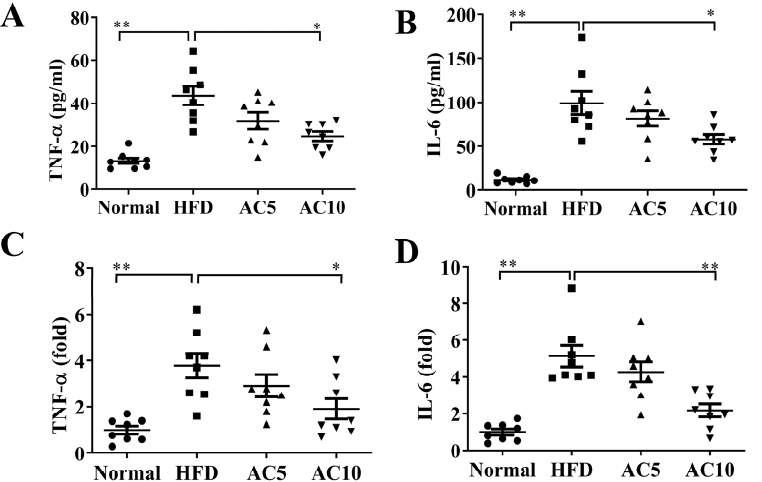
Figure 8. Acacetin (AC) reduced inflammatory response in mice. AC inhibited ( A ) TNF- α and ( B ) IL-6 levels in serum. ( C ) TNF- α and ( D ) IL-6 gene expression in liver tissue. The fold values were measured relative to β -actin expression. Values are presented as mean ± SEM. * p < 0.05, ** p < 0.01 compared to obese mice.